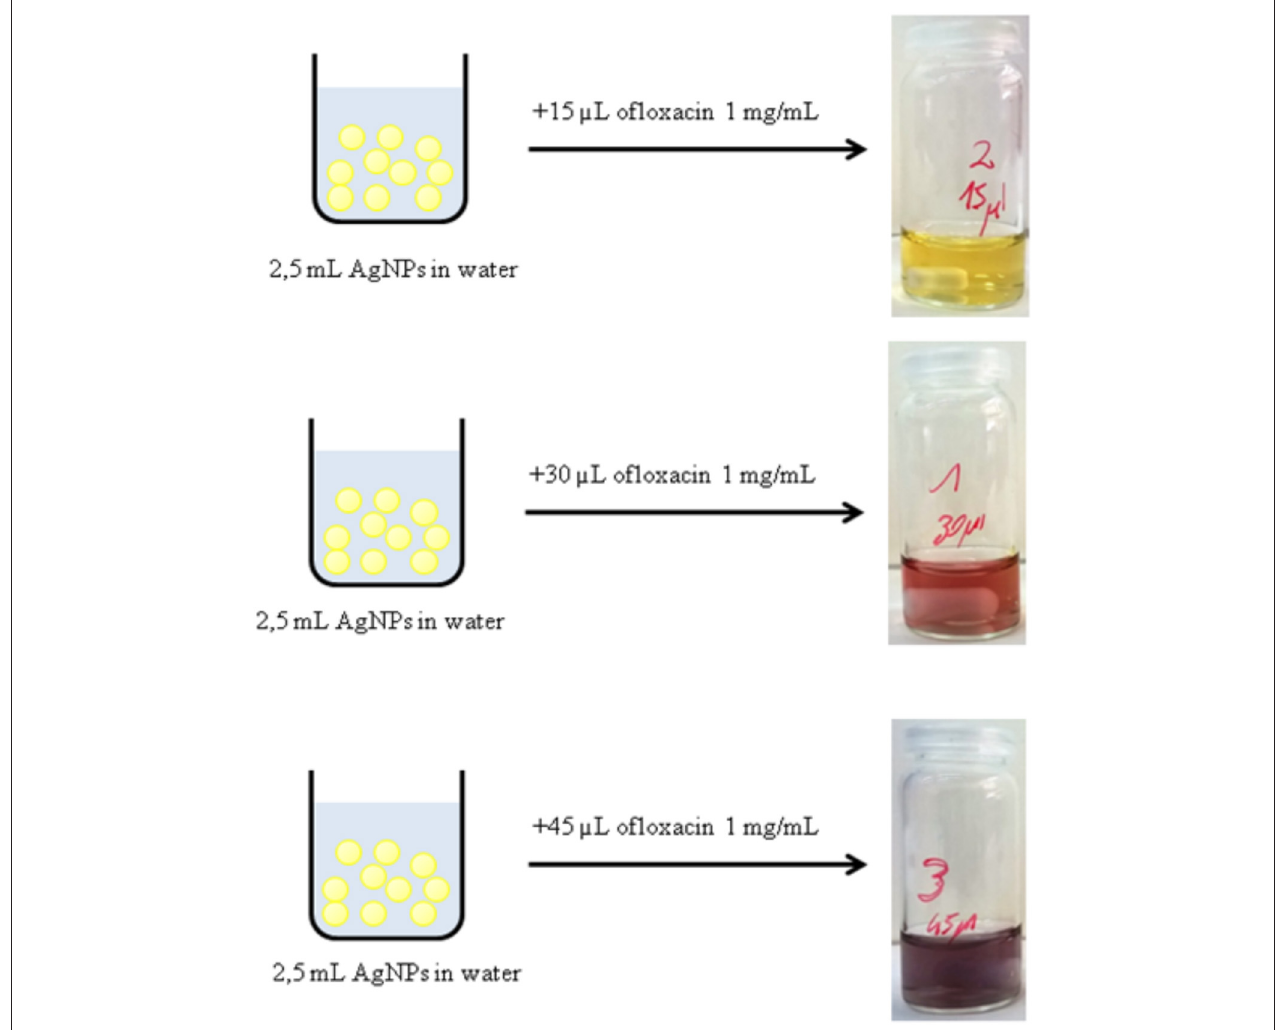
FIGURE 3 | Immediate color change of a solution of AgNPs after the addition of different amounts of a solution 1 mg/mL of